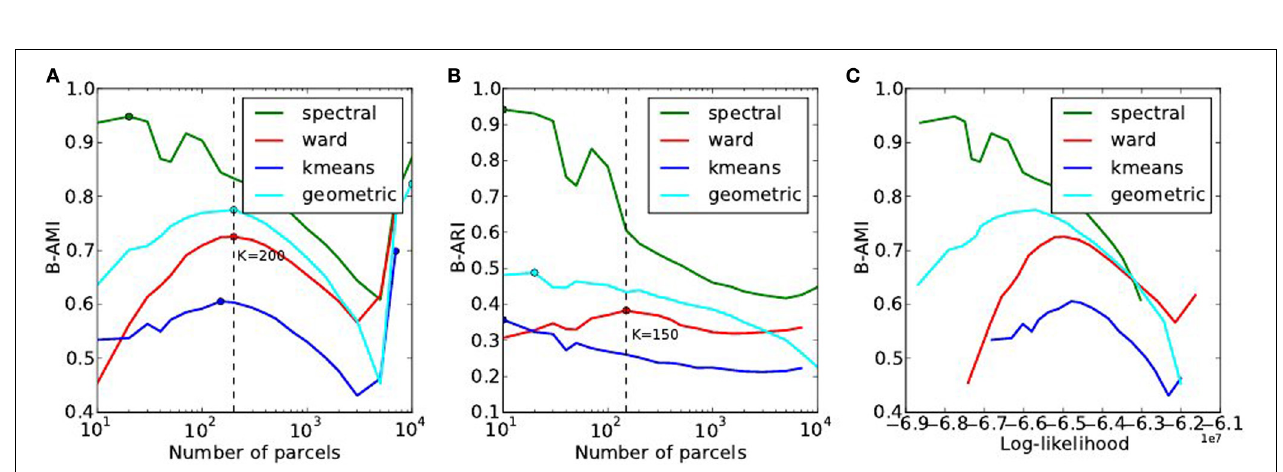
maximum on Ward’s parcellation. If we consider B-AMI against accuracy there is thus a trade-off region, for a number of parcels comprised between 200 and 5000 (decreasing portion of the curves in the reproducibility-accuracy curve), in which each setting represents a different compromise. The two dominant techniques are spectral clustering, that maximizes the reproducibility index, and Ward’s clustering, that yields higher accuracy